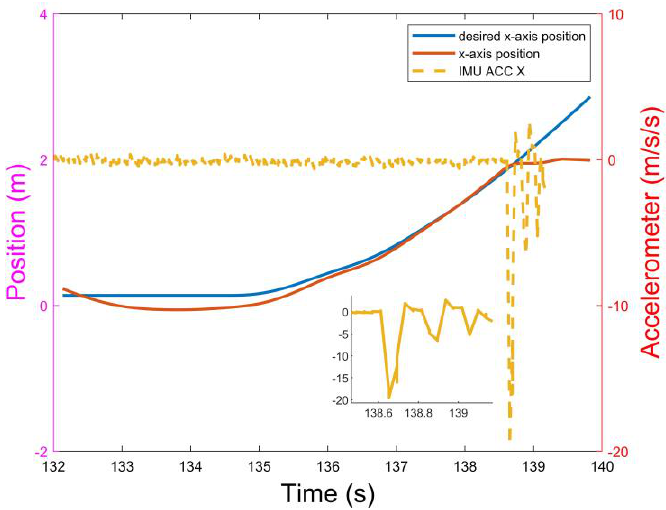
Figure 18. Process of the IMU-detecting robot contacting the wall.